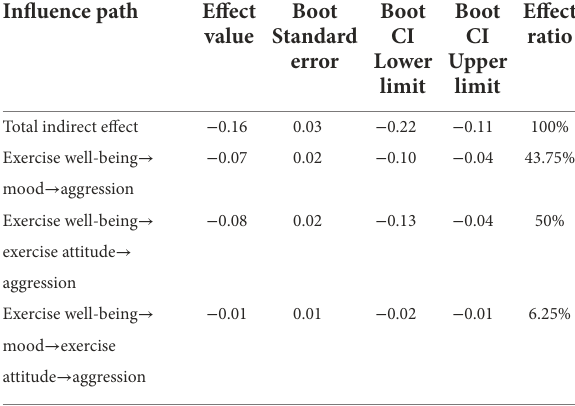
TABLE 2 Decomposition table of complete mediating effects of exercise